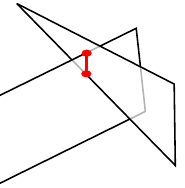
Figure 15: Combined intersection results of both polygons (intersection marked with red